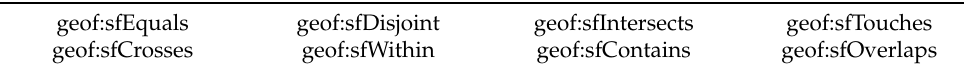
Figure 7. SWRL inference rule example.